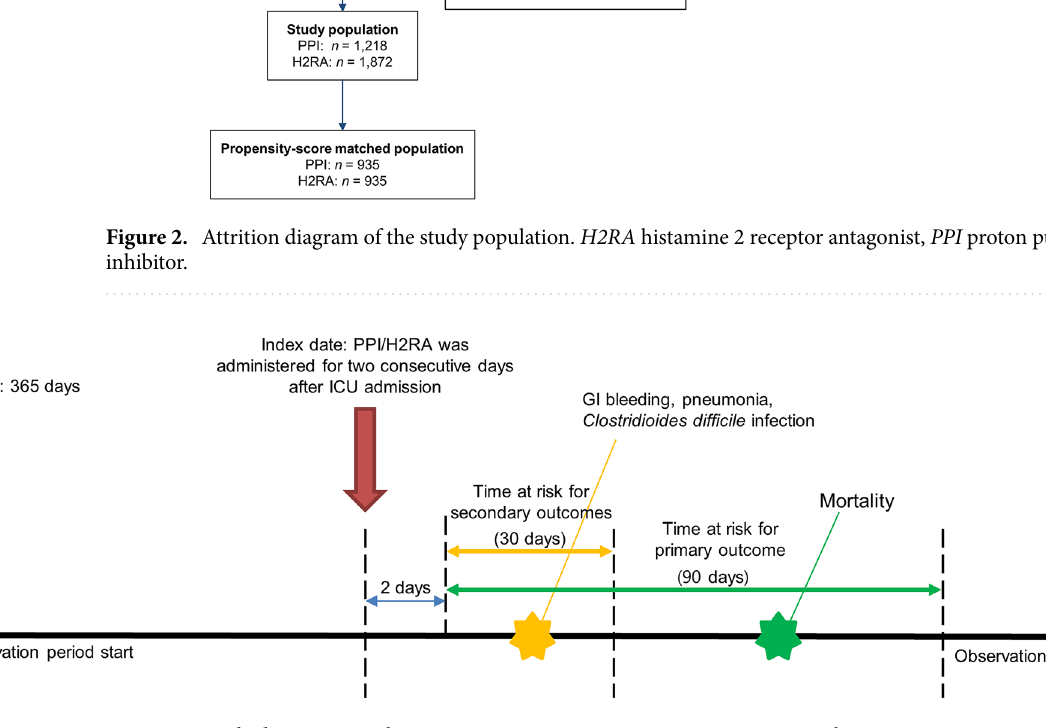
Figure 3. Study design. H2RA histamine 2 receptor antagonist, GI gastrointestinal tract, PPI proton pump